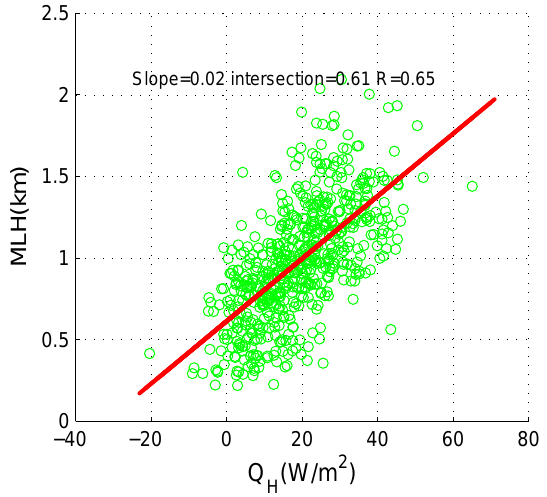
Figure 9. Correlation between the sensible heat ( Q H ) and MLH in